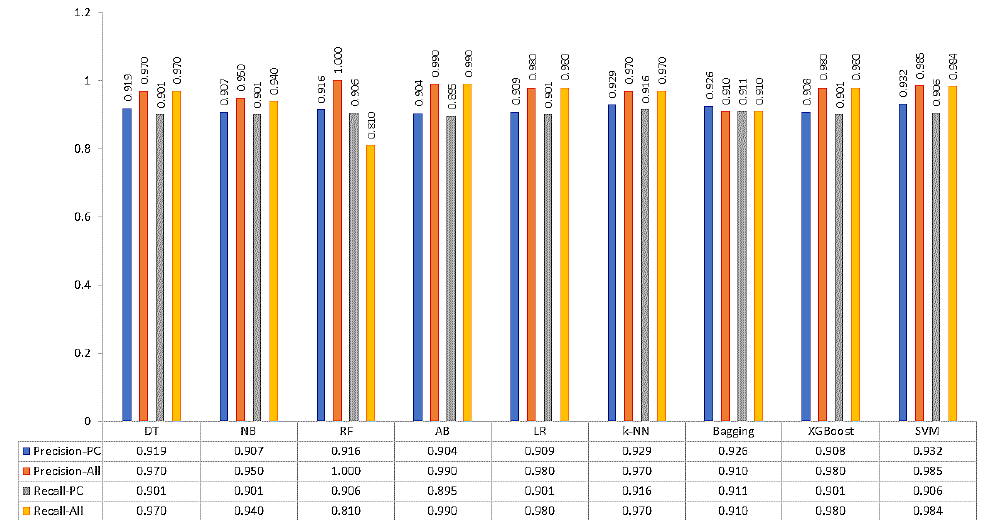
Figure 3. Precision and Recall values of ML methods with 66–34% split and PC-based FS